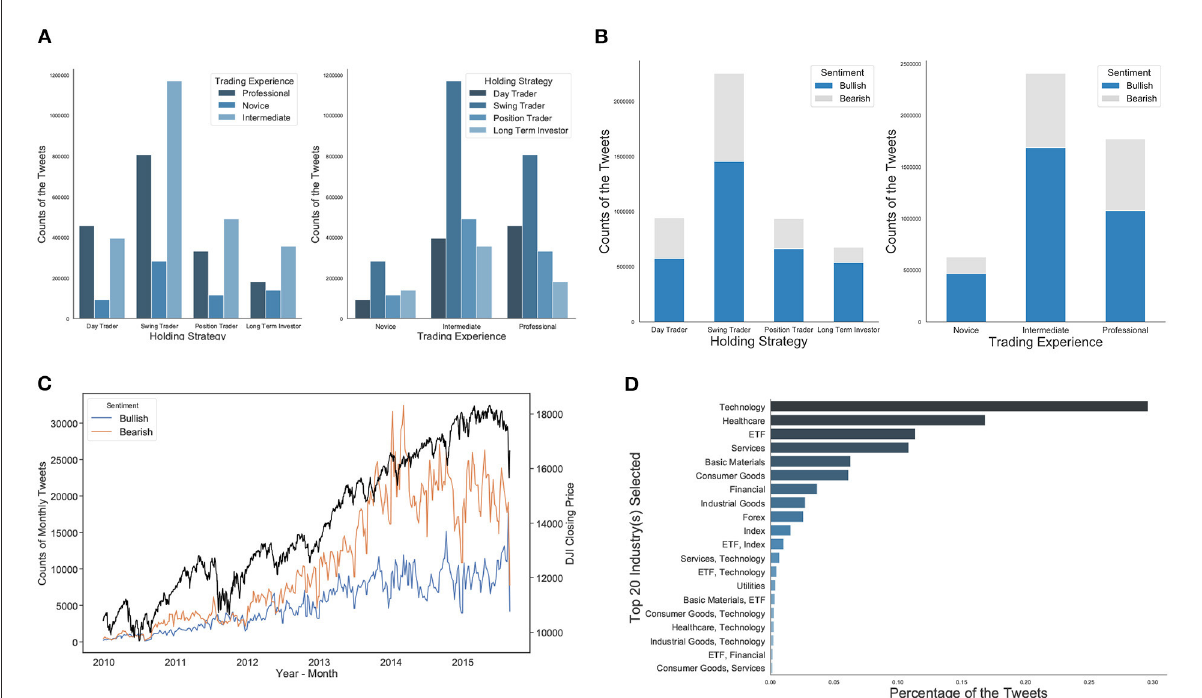
FIGURE2 (A) The distribution of posted tweets under the consideration of investors’ trading experience and holding strategy. Swing traders who aim to capture short- to medium-term gains over a few days and weeks contribute the most number of tweets. (B) The distribution of self-labeled bullish/bearish tweets on different factors of investors’ trading experience and strategy. There are more bullish tweets than bearish ones. Meanwhile, investors with intermediate experience (indicating a certain level of financial literacy) post the most number of tweets. (C) The trends of the monthly amounts of bullish/bearish tweets in comparison to Dow Jones Index (DJI) closing prices over the same period, demonstrating the differences between bullish and bearish investor sentiment follow similar trends of the DJI movement. (D) Top 20 asset categories discussed the most, listed by the number of associated tweets. Technology stocks, healthcare stocks, ETFs are among the top 3 most mentioned asset categories on